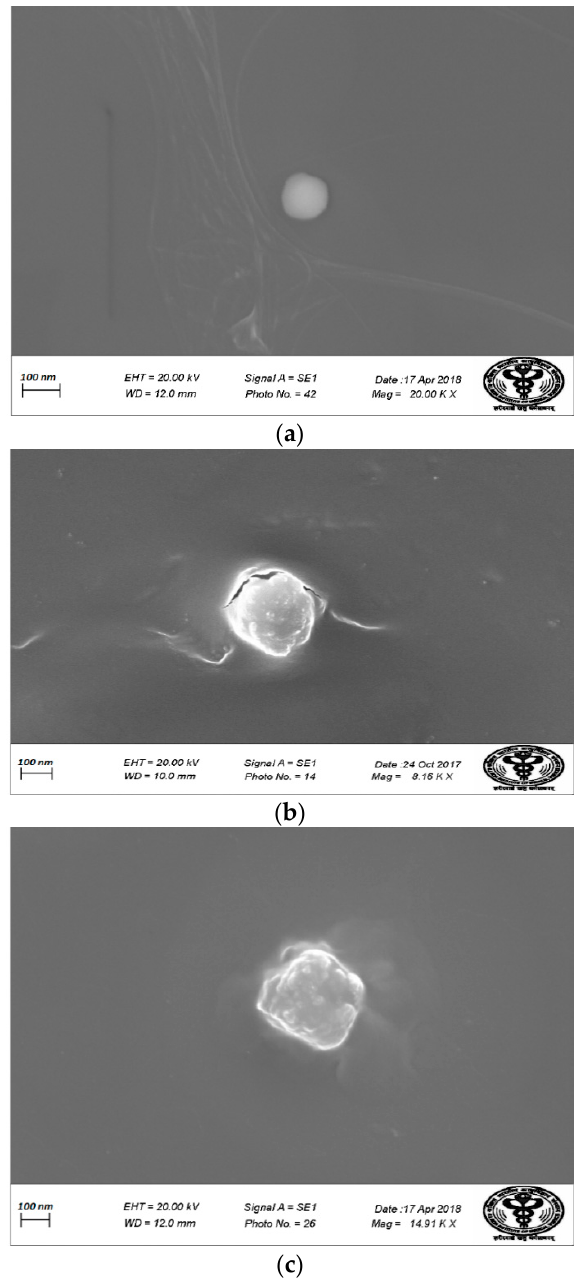
Figure 9. Scanning Electron Microscopy (SEM) images of ( a ) Blank Liposomes; ( b ) Dacarbazine and Eugenol Liposomes; ( c ) Dual loaded surface-functionalized liposomes. ( a ) More spherical and round liposomes ( b ) Liposomes are bigger in size ( c ) Surface of liposomes appear irregular due to surface coating.